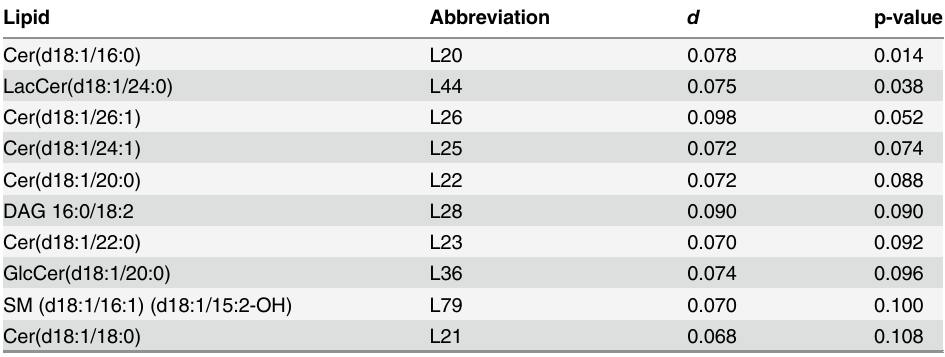
Table 2. The 10 most differentially connected lipids for MI LURIC data based on the test for differential connectivity of individual lipids between case and control groups.